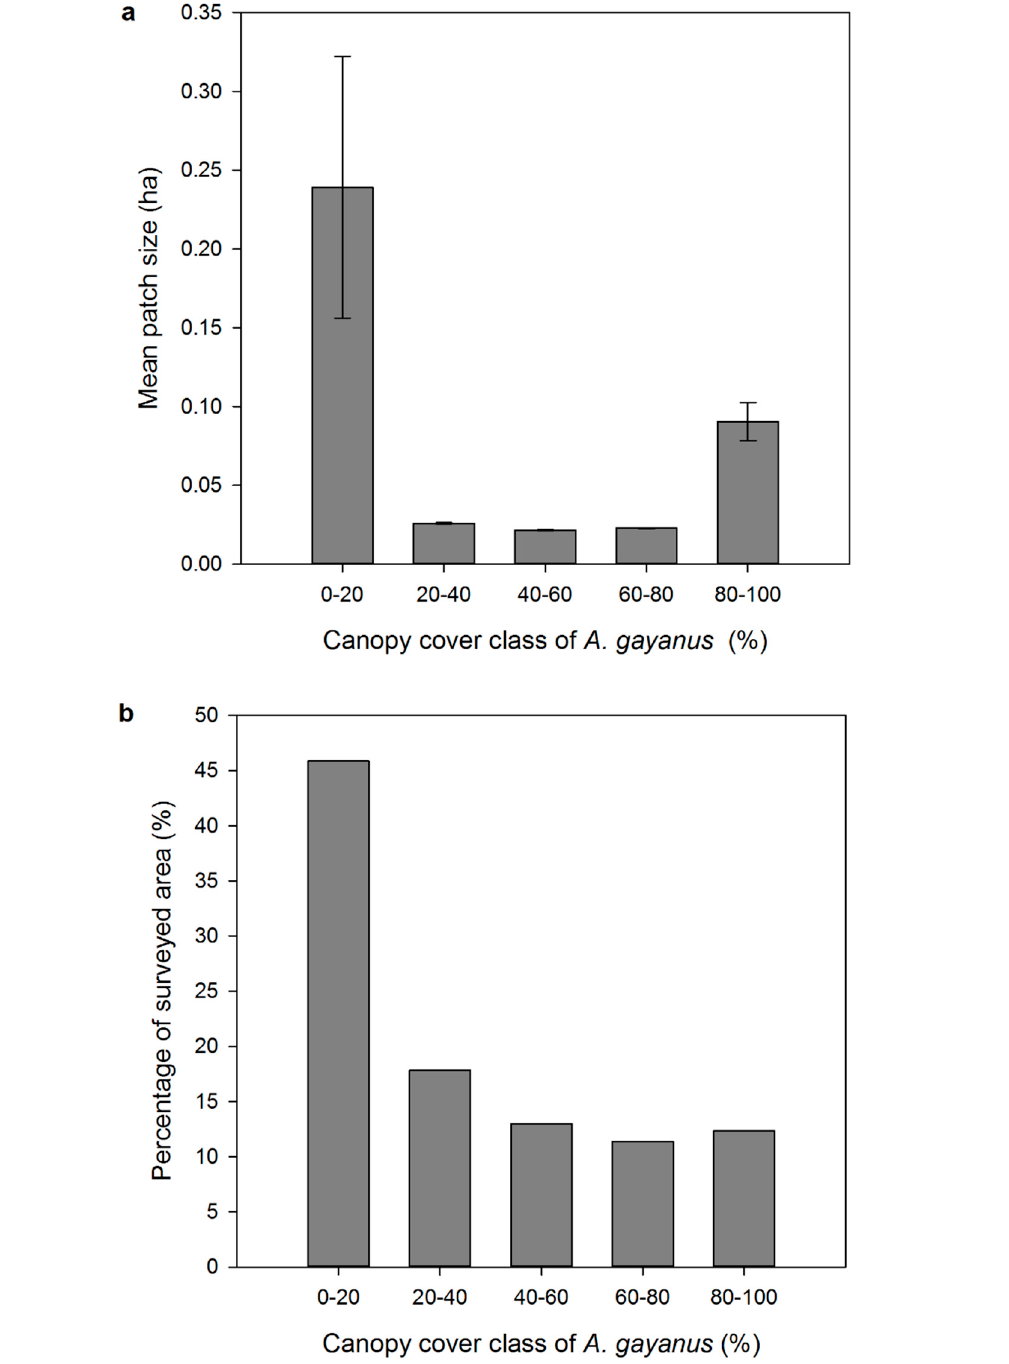
Figure 6. Patch metrics for five classes of A. gayanus canopy cover mapped with airborne LiDAR. ( a ) Mean size of spatially contiguous patches of five canopy cover categories. ( b ) Percentage of total area surveyed for each of the five canopy cover